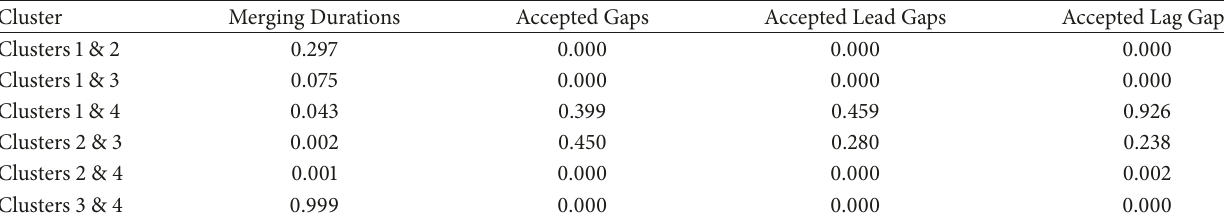
Table 5: Mann–Whitney 𝑈 test results between different clusters.